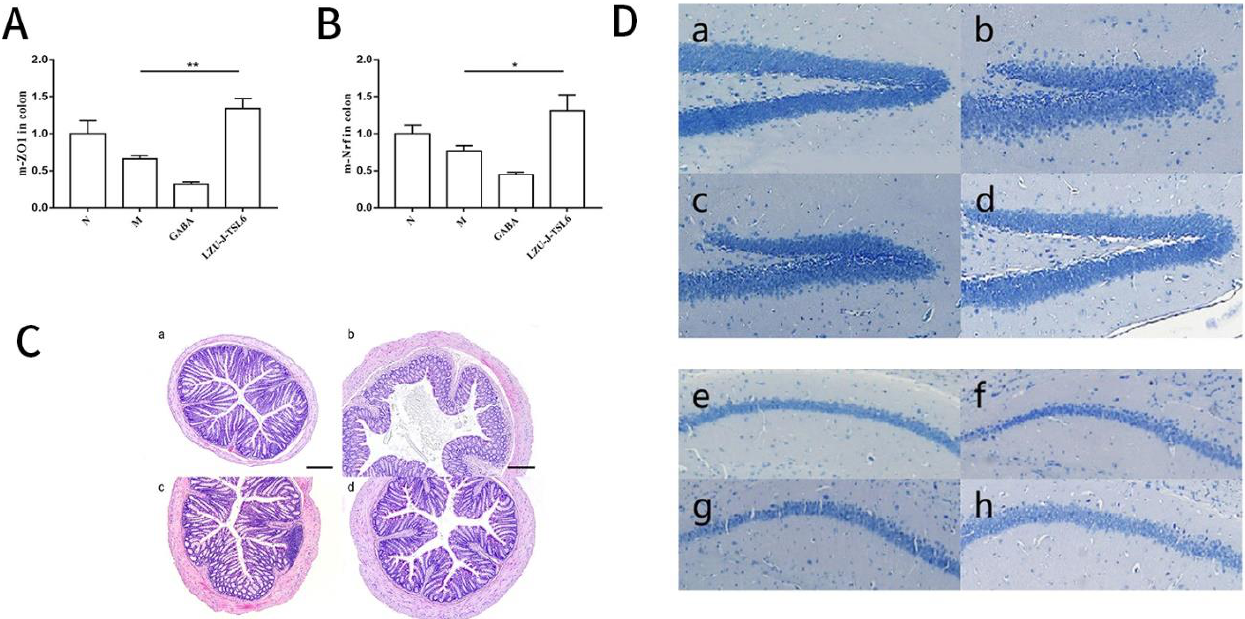
Figure 4. The effect of LZU-J-TSL6 on the intestinal environment and hippocampus tissue of mice with anxiety: The expression of Nrf-2 and ZO-1 genes in the colon tissues of mice in each group ( A , B ). Observation of HE staining of colon tissue of mice in each group ( C ). (( a ). Control group; ( b ). Model group; ( c ). GABA group; ( d ). LZU-J-TSL6 group). Observation of Nissl body staining in the DG and CA1 regions of the hippocampus of mice in each group ( D ). (( a , e ): Control group; ( b , f ): Model group; ( c , g ): GABA group; and ( d , h ): LZU-J-TSL6 group). Bars show the mean ± SD ( n = 5 mice per group) * p < 0.05; ** p < 0.01.